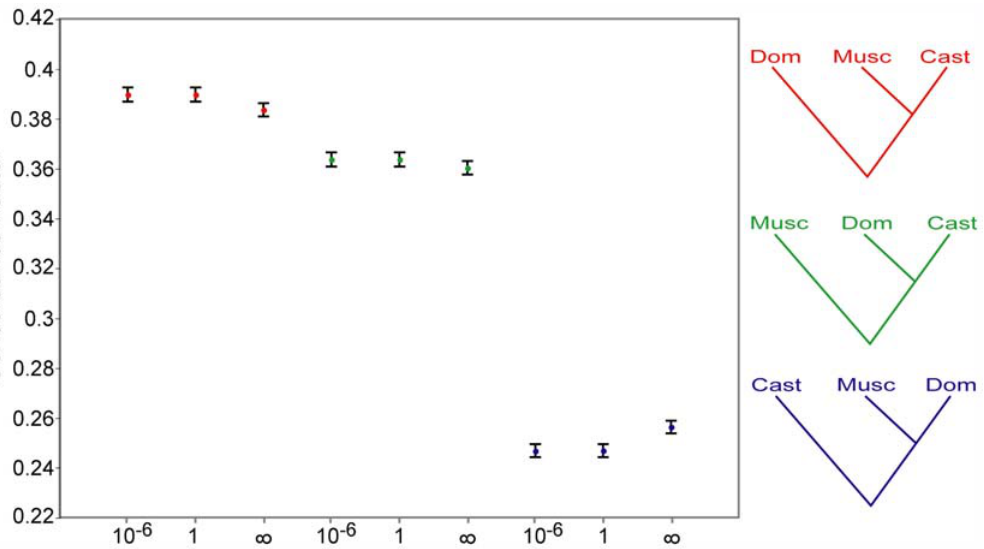
Figure 3. Genome-wide phylogenetic discordance. Bayesian concordance factors were calculated from the posterior probability distributions of 14,081 single-locus phylogenetic analyses. The concordance analysis is depicted using three different priors on gene tree concordance: complete independence among loci ( a = infinity), a high probability of concordance among loci ( a =10 2 6 ), and an intermediate level of concordance ( a =1). The M. m. musculus / M. m. castaneus topology is supported by significantly more loci than the other two topologies regardless of the prior on gene tree concordance. Colors correspond to the three topologies. Error bars are 95% credibility intervals.